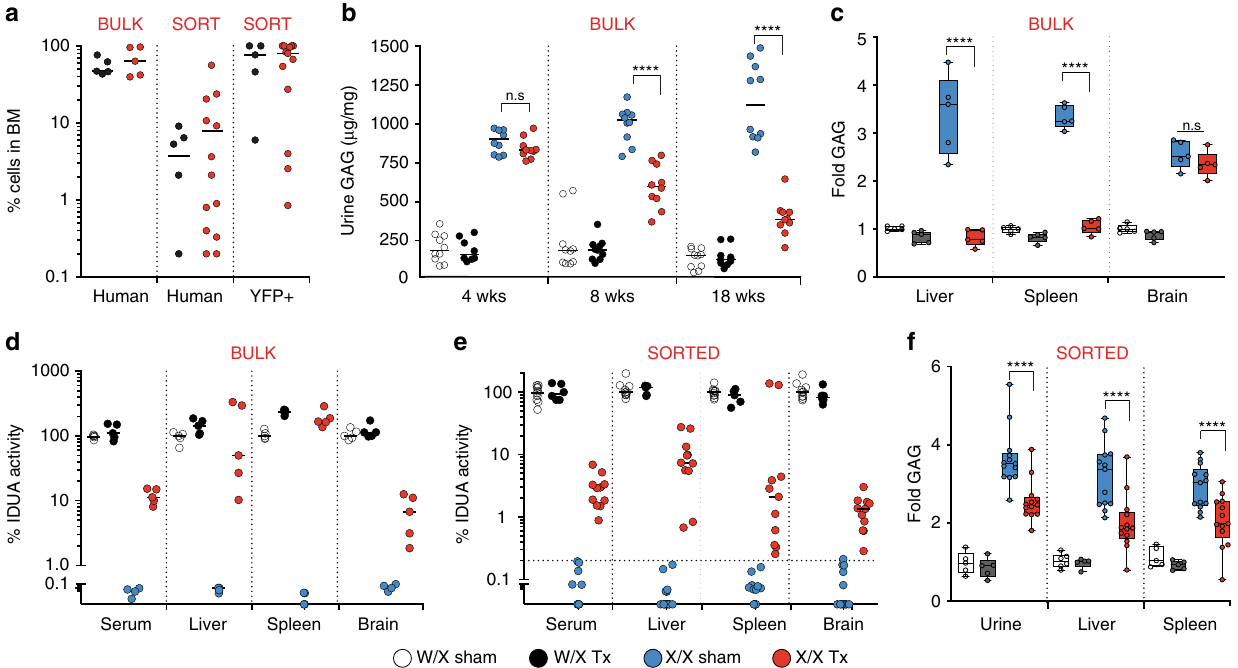
Fig. 4 Biochemical correction in NSG-IDUA X/X mice by human IDUA-HSPCs. IDUA activity and GAG accumulation in heterozygous sham-treated (W/X sham- clear), heterozygous transplanted (W/X Tx- black), homozygous sham-treated (X/X sham- blue), and homozygous transplanted (X/X Tx- red) mice. a Percent human and YFP + cells in BM in experiments using bulk and sorted cells. b Urinary GAGs at 4,8, and 18 weeks in experiments using bulk cells ( n = 5 mice per cohort, two measurements per mouse). c Plasma and tissue IDUA activity in experiments using bulk cells ( n = 5 per cohort). d Fold GAG storage in liver, spleen, and brain (normalized by W/X sham, n = 5 per cohort). e Plasma and tissue IDUA activity in experiments using sorted cells ( n = 5 for W/X Tx and sham mice, and n = 13 for X/X Tx and sham mice). f Fold GAG urinary excretion and tissue storage in experiments using sorted cells (normalized by W/X sham). Median values shown in all scatter plots. d , f shows box plots with whiskers at the 5 – 95th percentiles. **** p < 0.0001 in one-way ANOVA test. Post hoc comparisons were made with the Tukey ’ s multiple comparisons test. Source data are provided as a Source Data fi